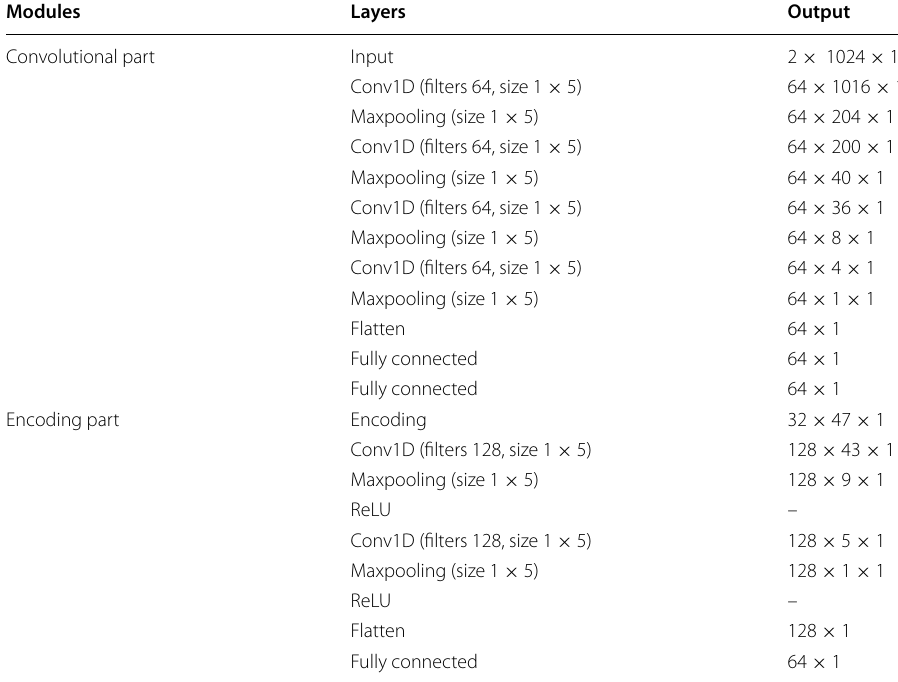
Table 1 Layers of semantic generation module and output dimensions of each layer